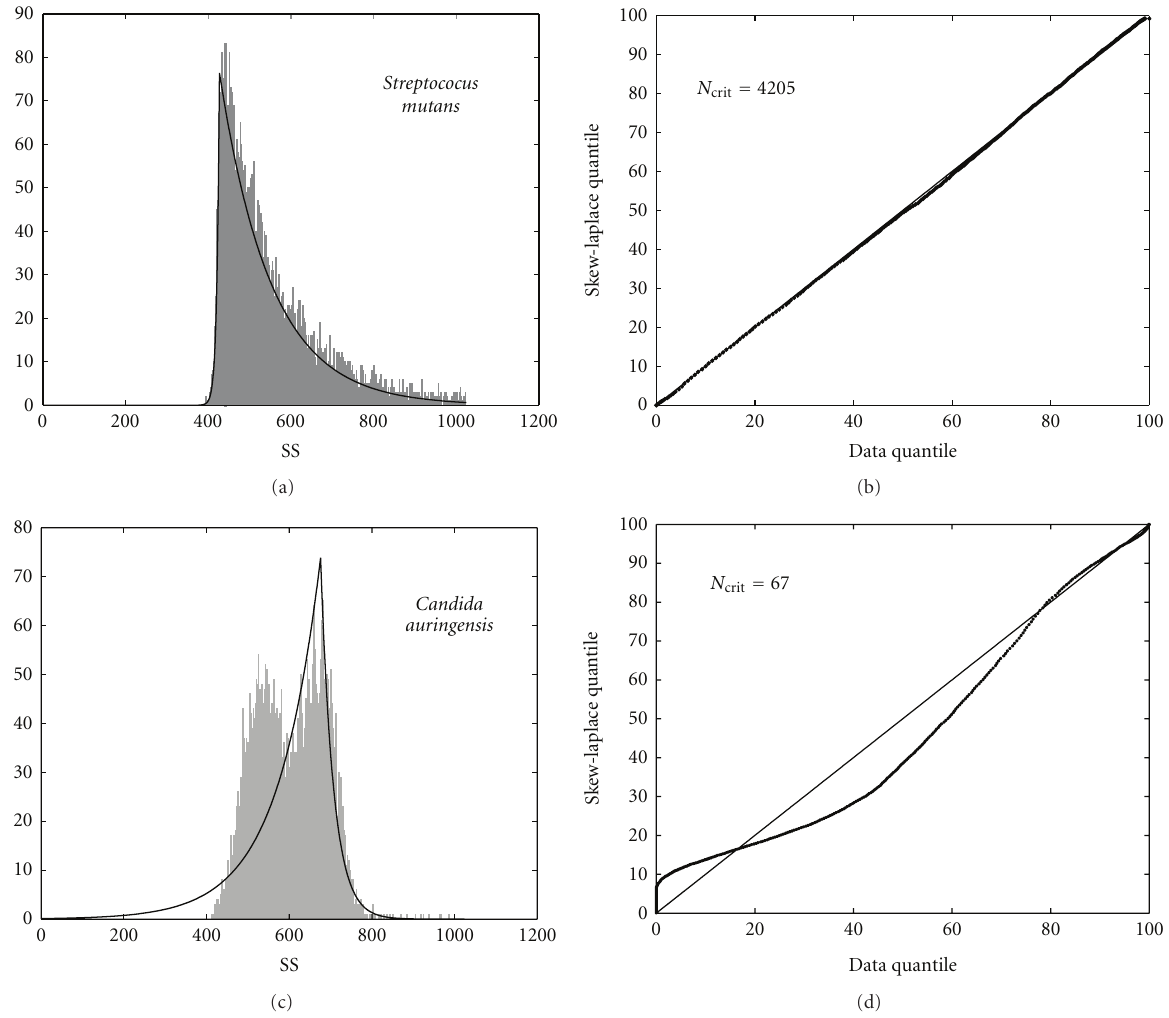
Figure 1: Left: skew-Laplace fit of SS from Streptococcus mutans and Candida auringensis batch culture after 24 hours of incubation. The data histogram appears in grey shadow and the continuous profile represents the estimated skew-Laplace fit. Right: Quantile plot validation ( N crit is the critical number as defined in the Section 2 and for which maxima are reported in Table 1). On the Y -axis are the skew-Laplace quantile and on the X -axis the data